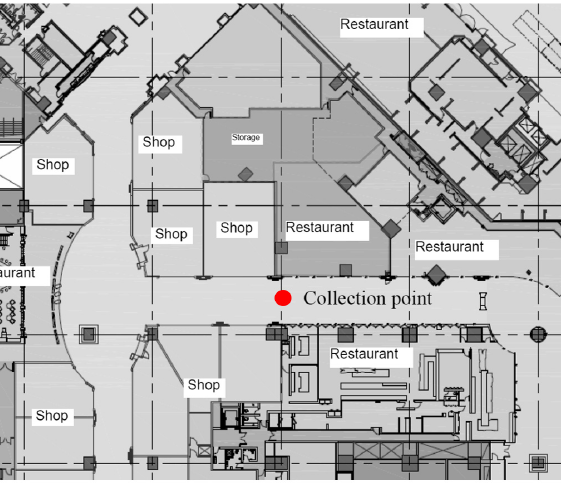
Figure 3. Layout of public area.